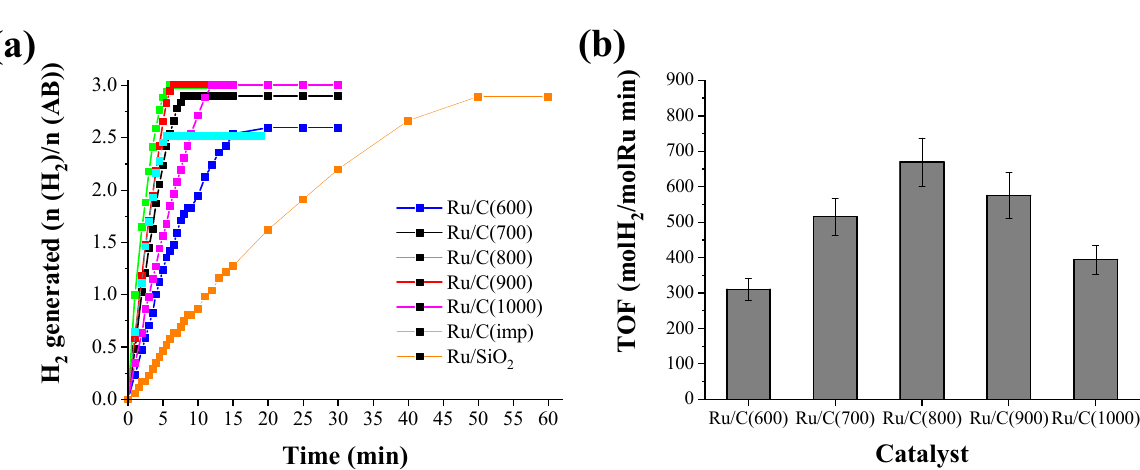
Figure 3. ( a ) Catalytic activity of the Ru-based catalysts in the AB hydrolysis reaction at 30 °C. ( b ) Turnover frequency (TOF) number (mol H2 · mol Ru − 1 · min − 1 ) calculated at t = 5.5 min for the Ru/C samples prepared by Ru complex decomposition. The average TOF numbers were calculated after performing three different catalytic tests. Adapted with permission from [79].